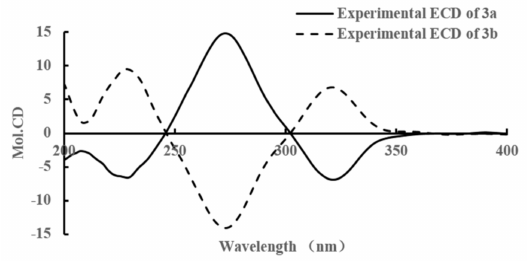
Figure 4. The circular dichroism (CD) Spectrum of compounds 3a and 3b in MeOH.